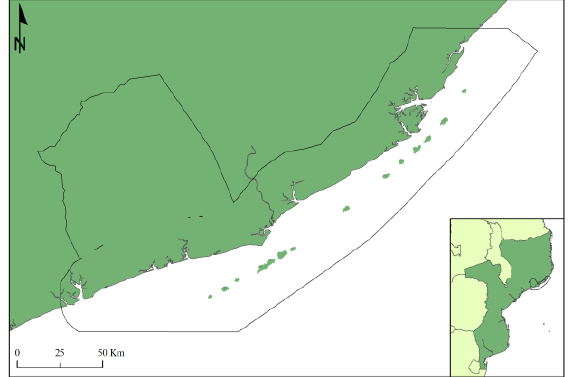
Figure 1. PSEPA’s location, in Mozambican coastline, between 16° 12’S and 17° 17’S. The Archipelagos are located parallel to the